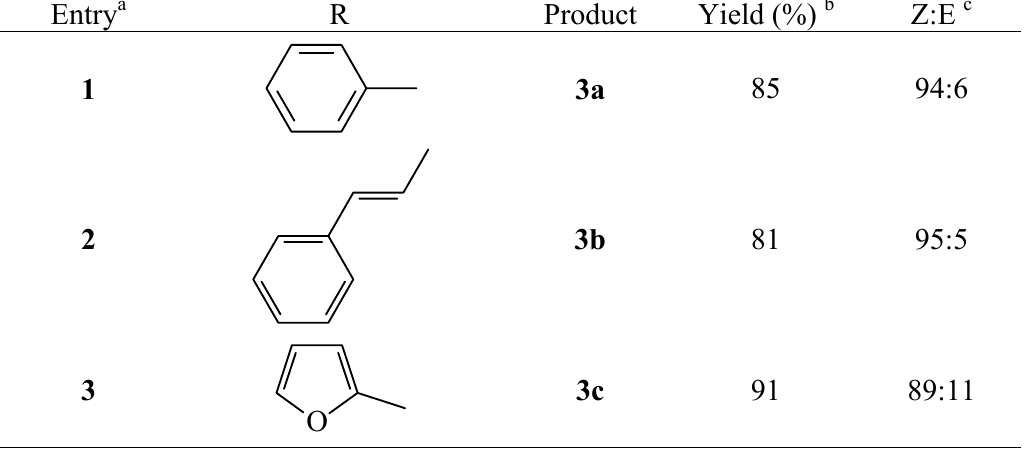
Table 1. One-pot synthesis of ( Z )- α -Iodo- α , β -unsaturated